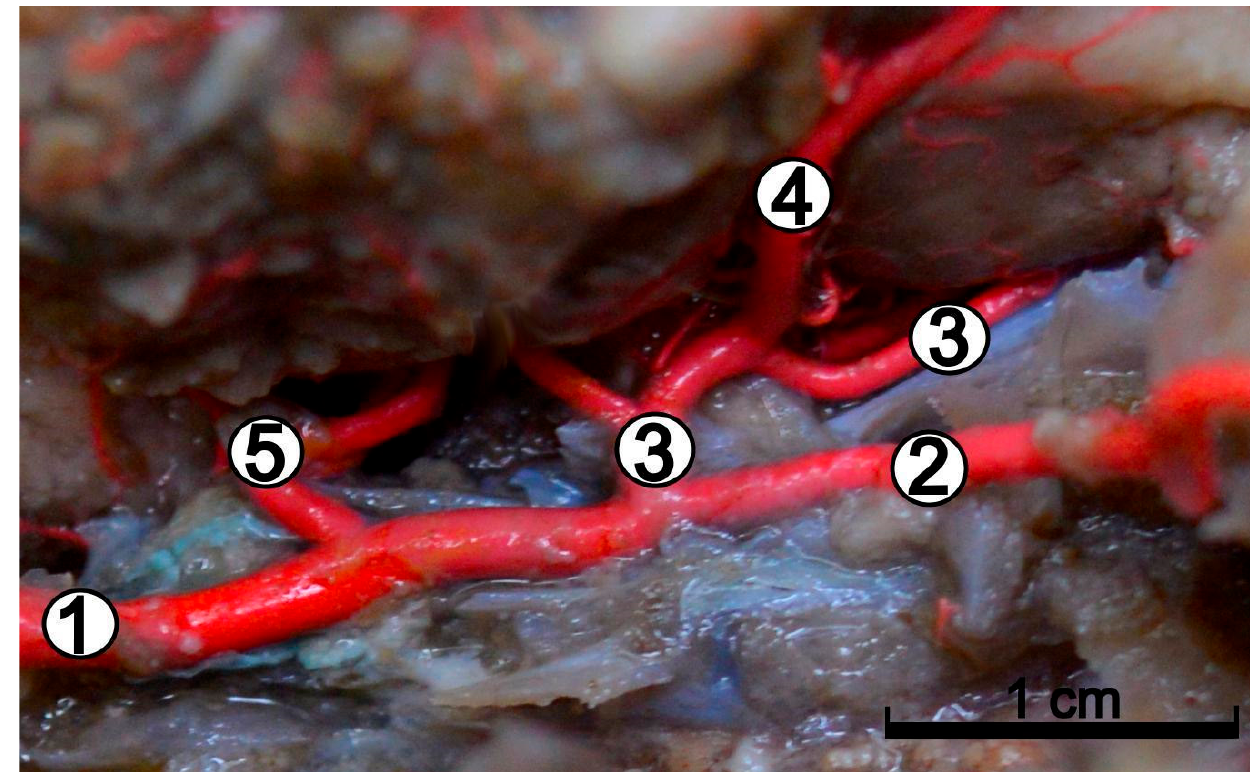
Figure 2. Branches of the internal carotid artery in the cranial cavity between the brain and the base of the skull. Latex preparation. 1—internal carotid artery; 2—internal ophthalmic artery; 3—rostral cerebral artery; 4—middle cerebral artery; 5—caudal communicating artery. After passing through it, the internal ophthalmic artery ( arteria ophthalmica interna ), was observed to enter the orbit. The internal carotid artery was a strong vessel over its entire length. It divided into the internal ophthalmic artery and the rostral cerebral artery ( arteria cerebri rostralis ) (Figures 1 and 2). At that point, the diameters of these vessels be- came smaller. The rostral choroidal artery ( arteria choroidea rostralis ), which runs dorsally between the temporal lobe of the brain and the cerebral crus, branched off from the be- ginning segment of the rostral cerebral artery. The rostral cerebral artery gave way to the middle cerebral artery ( arteria cerebri media ), a vessel with a large diameter (Figure 2). It ran dorsally, and surrounded the piriform lobe from its rostral side, and divided into nu- merous branches. The middle cerebral artery branched off into four main branches (Figure 3).